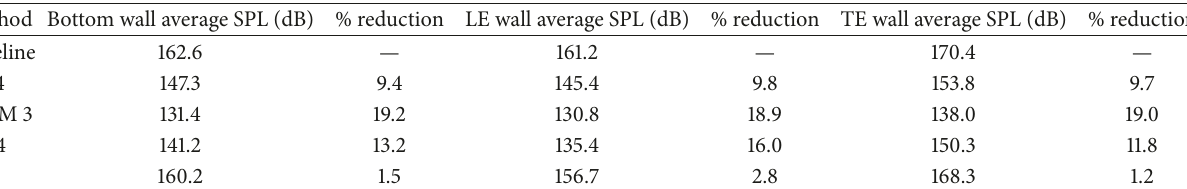
Table 7: Comparison of sound pressure levels for the most effective cases and the baseline.